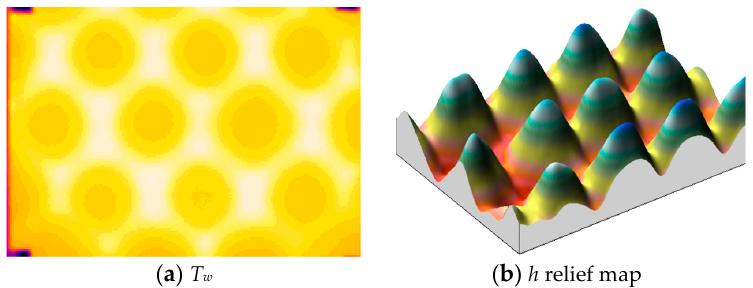
. m = 9 kg/ m 2 s : ( a ) wall temperature; ( b ) heat